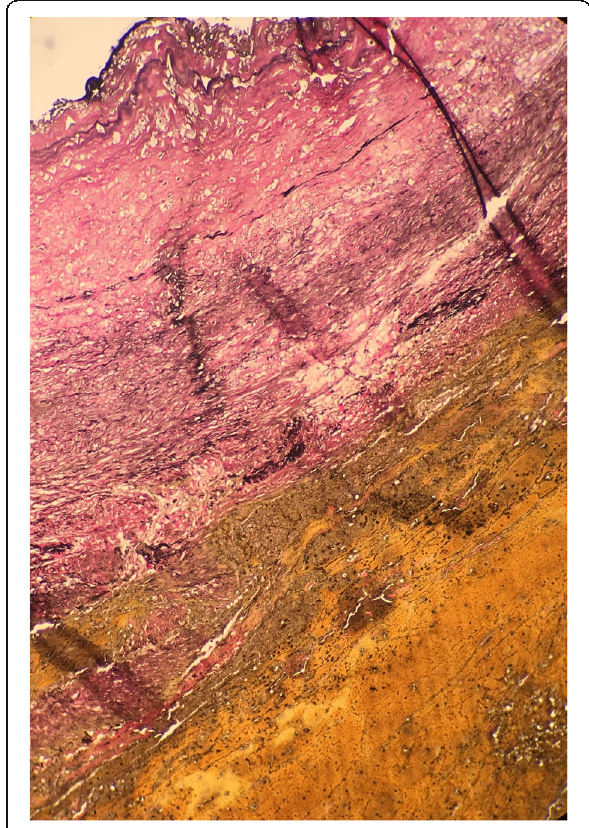
Fig. 6 Disrupted internal elastic lamina in the aneurysmal wall under EVG staining (arrow) (10× magnification)